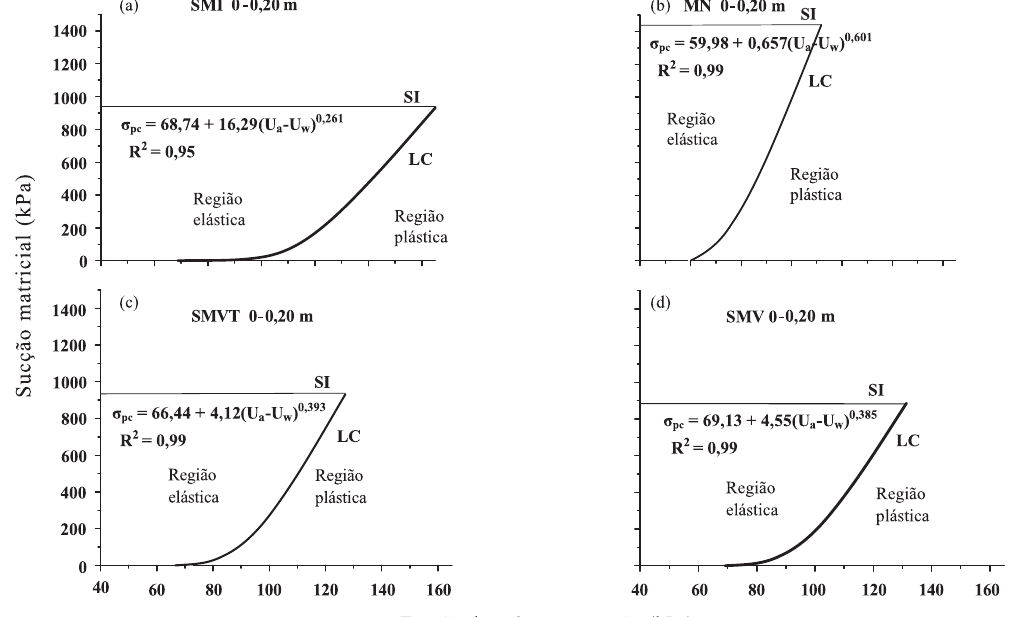
figura 2. sucção matricial em função da tensão de pré-compactação, para as quatro condições de sistemas de manejo, na profundidade de 0–0,20